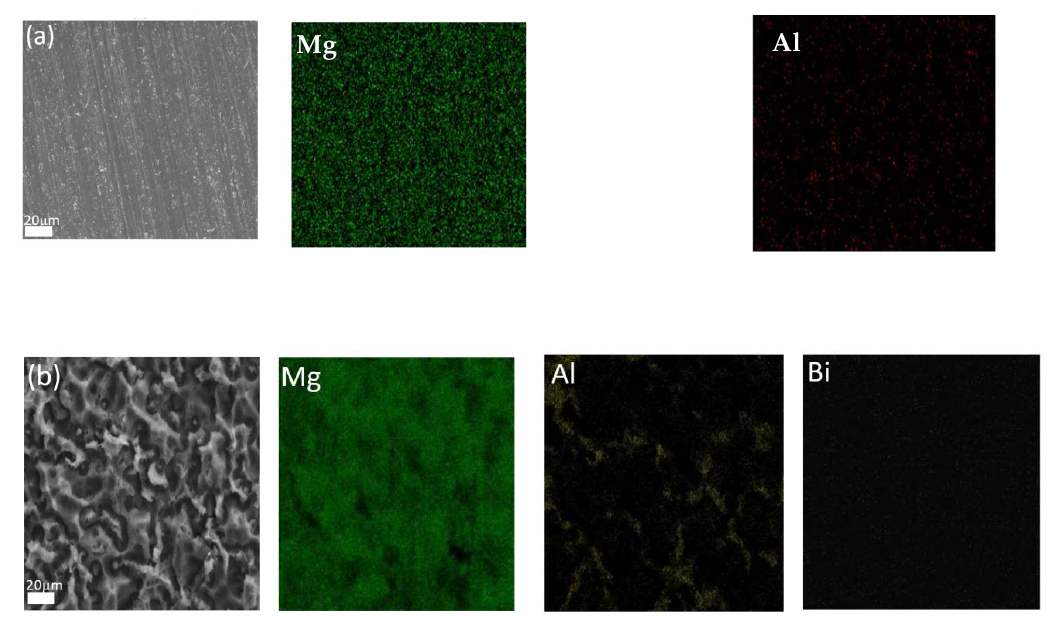
Figure 7. Element mapping of elements Mg, Al, and Bi for ( a ) as-cast Mg–8%Al–0.4%Bi and ( b ) Mg–8%Al–0.4%Bi alloy discharged at 120 mA/cm 2 for 30 min without discharge products.